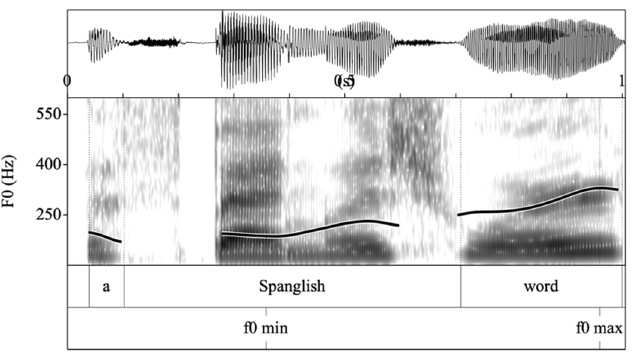
Figure 1. Example of uptalk with IP-final deaccenting in English produced by a female heritage bilingual (HS2). “ A Spanglish word ”. bilingual (HS2). “ A Spanglish word